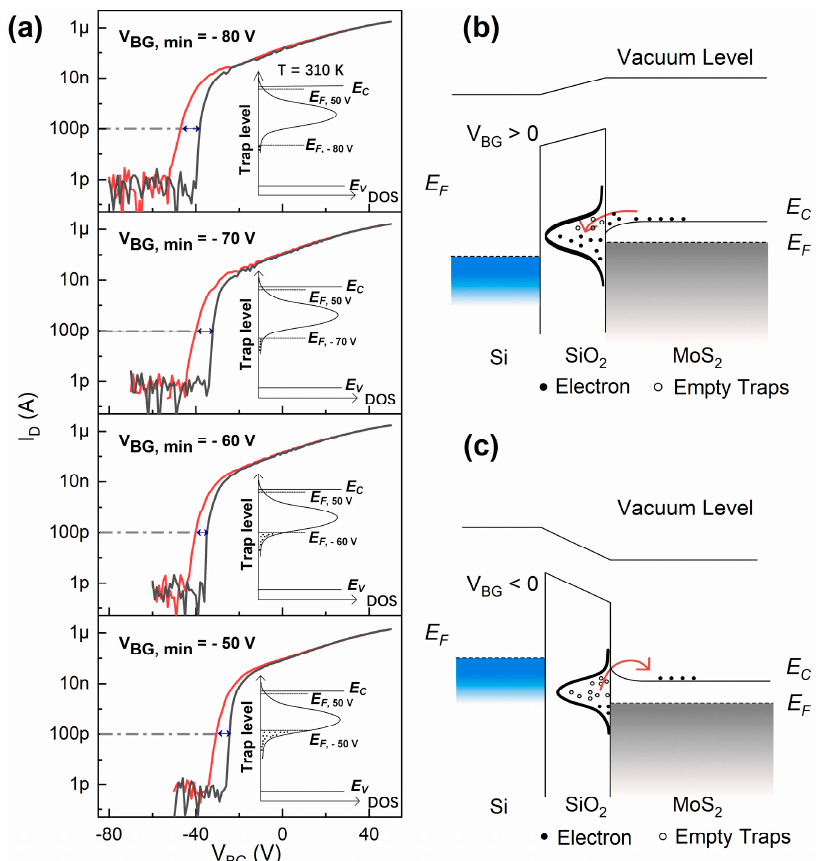
Figure 2. ( a ) The transfer curves for forward sweep (red line) and backward sweep (black line) measured at 310 K. The hysteresis is selected as the voltage shift between the transfer curves of the forward sweep and the backward sweep at I DS = 100 pA, which is indicated by a double-headed arrow. The inset shows the positions of the Fermi level corresponding to V BG, min s of − 50 to − 80 V, respectively. ( b , c ) The band structure of MoS 2 channel considering the interface states at the MoS 2 –SiO 2